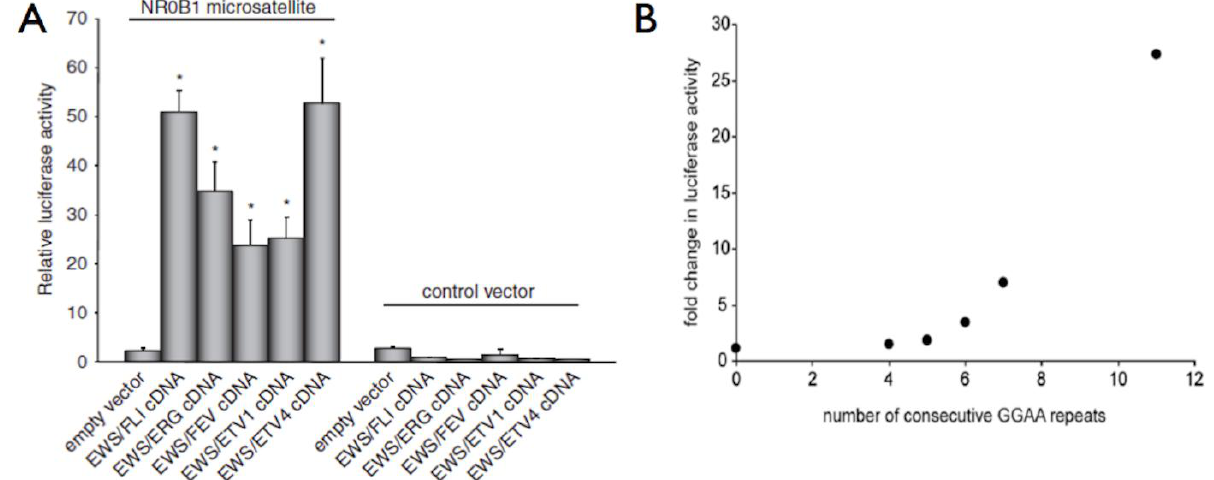
Figure 3. EWS/ETS fusion proteins bind DNA and regulate gene expression via a GGAA microsatellite response element. ( a ) In luciferase reporter constructs, all five EWS/ETS fusions can activate gene expression via the 102 bp NR0B1 microsatellite; ( b ) Using similar reporter constructs, an increasing number of GGAA motifs, beyond a threshold of Gangwal et al ., Genes Cancer . 2010 February 1 ; 1 ( 2 ): 177 (cid:177) 187